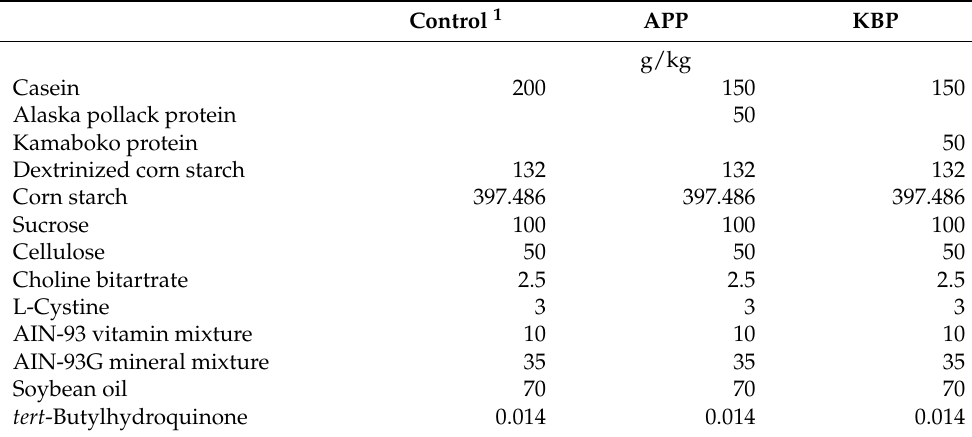
Table 1. Composition of the experimental